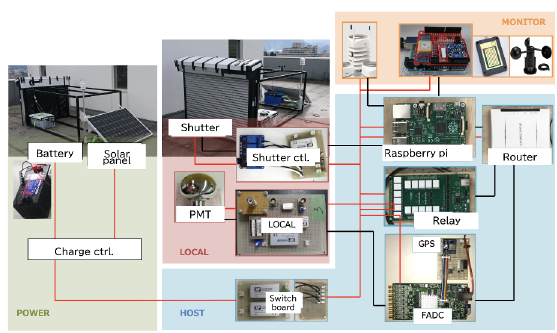
Figure 12. Block diagram of the automation system of CRAFFT for long-term tests at Shinshu University.